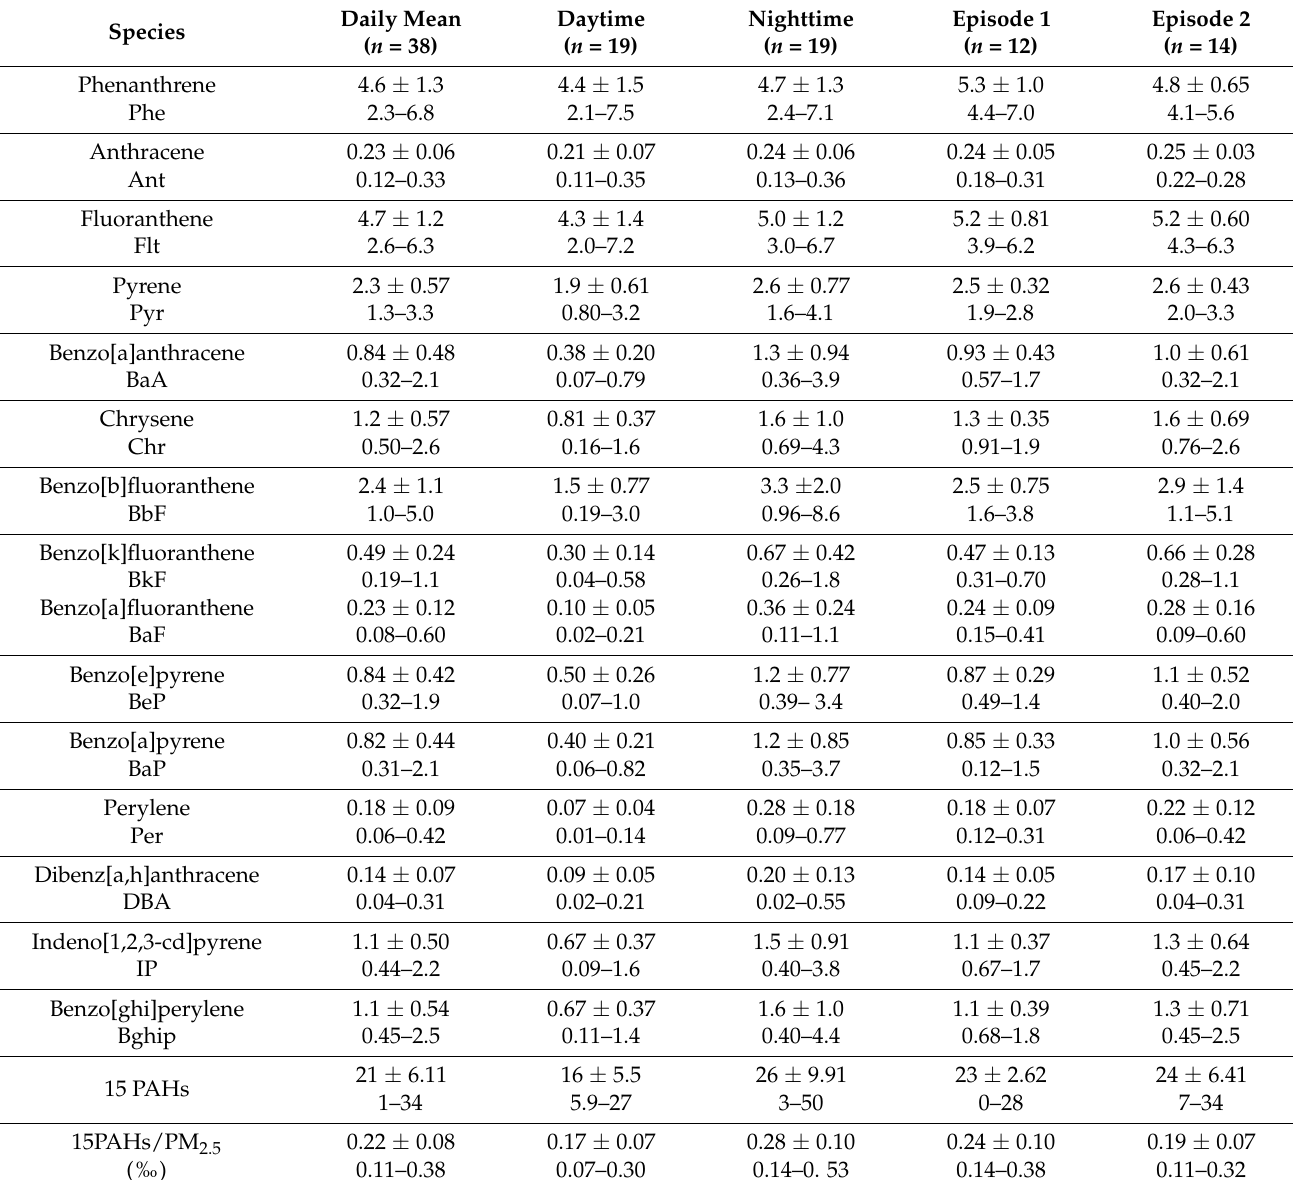
Table 3. Mean and ranges of mass concentrations of PAHs in the study area during the monitoring period (ng/m 3 ).